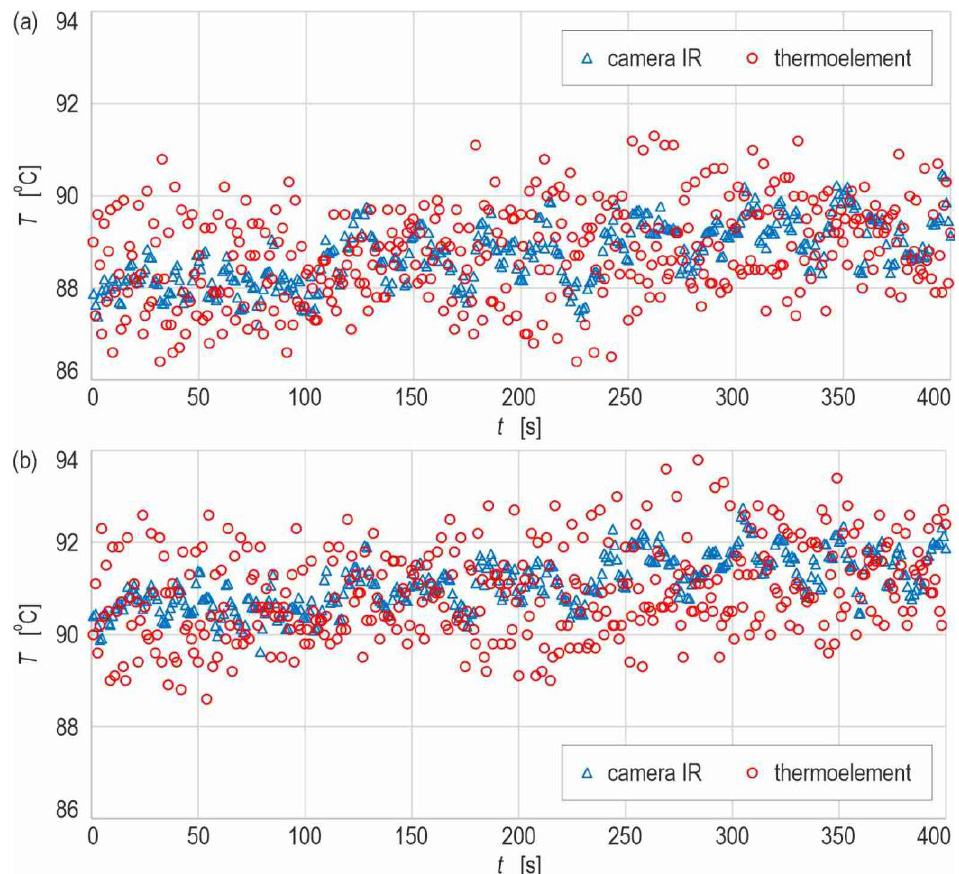
Figure 5. Temperature measurements performed by the thermoelements and the infrared camera, at the same distance from the inlet, corresponding to the thermoelement positions: Nos. 5 ( a ) and 8 ( b ).